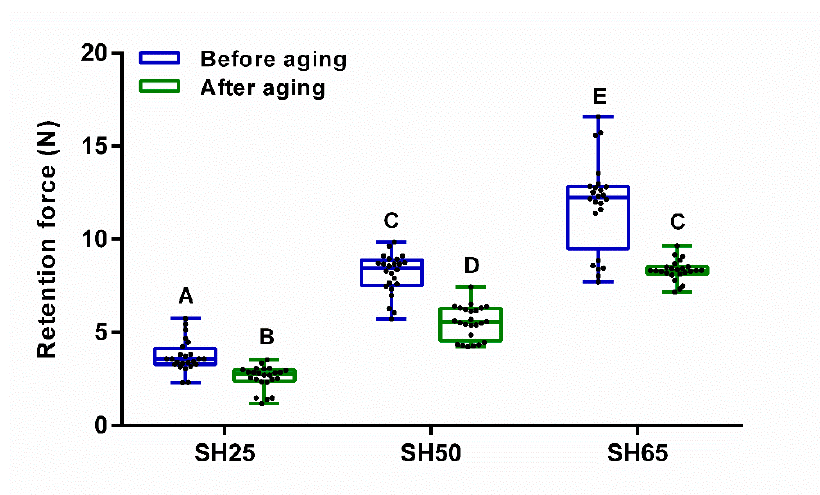
Figure 5. Box-and-whisker plot of retention force for the PVS attachments with three different degrees of Shore hardness (SH25, SH50, and SH65) before and after the aging treatment. Black dots represent each measurement (n = 24). Different letters indicate a statistically significant difference, determined by two-way ANOVA (Tukey’s multiple comparisons test; p < 0.05). The “A”, “B”, “C”, “D” and “E” letters indicate the level of statistical difference between each group.